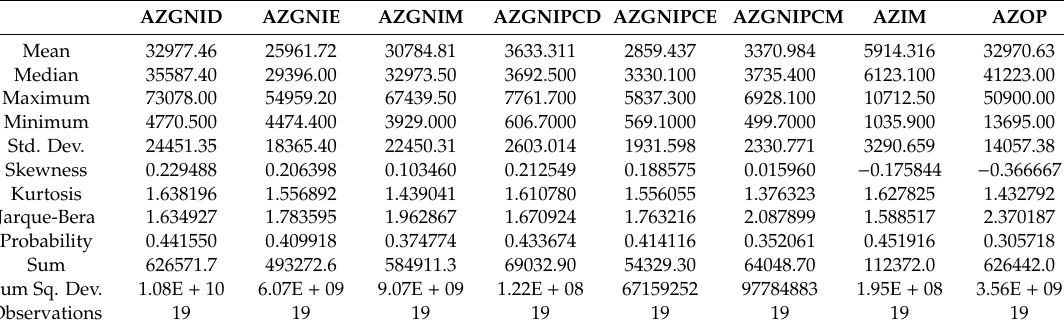
Table A5. AZ. Descriptive